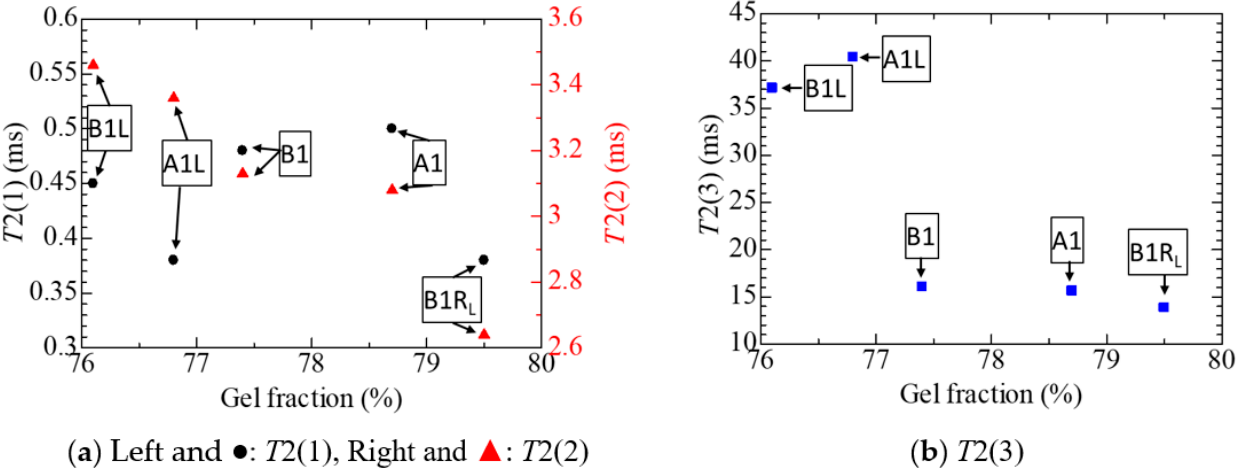
Figure 11. Three transverse relaxation times of the five tubular samples and their dependence on gel fraction. ( a ) ● : T 2(1) and ▲ : T 2(2), ( b ) ■ : T 2(3).